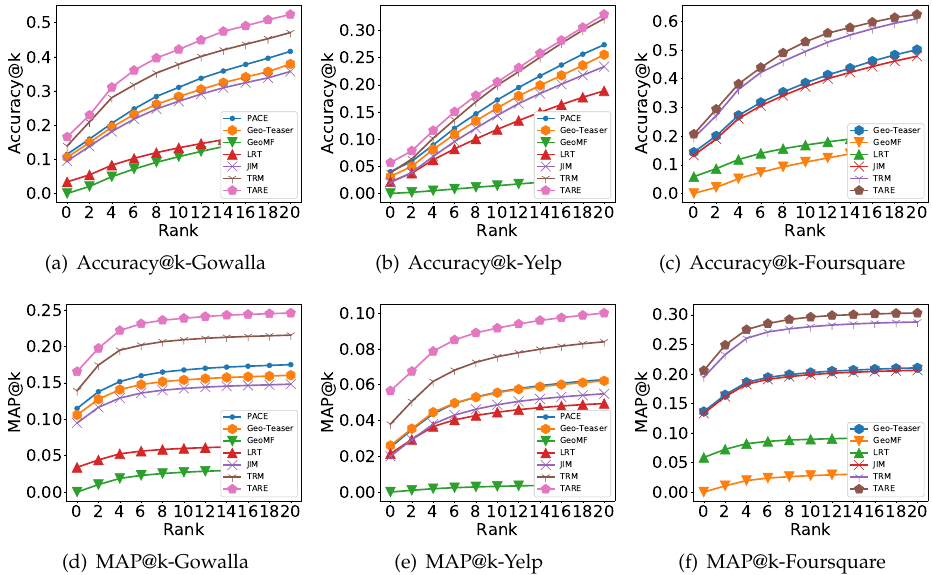
Figure 3. Performance